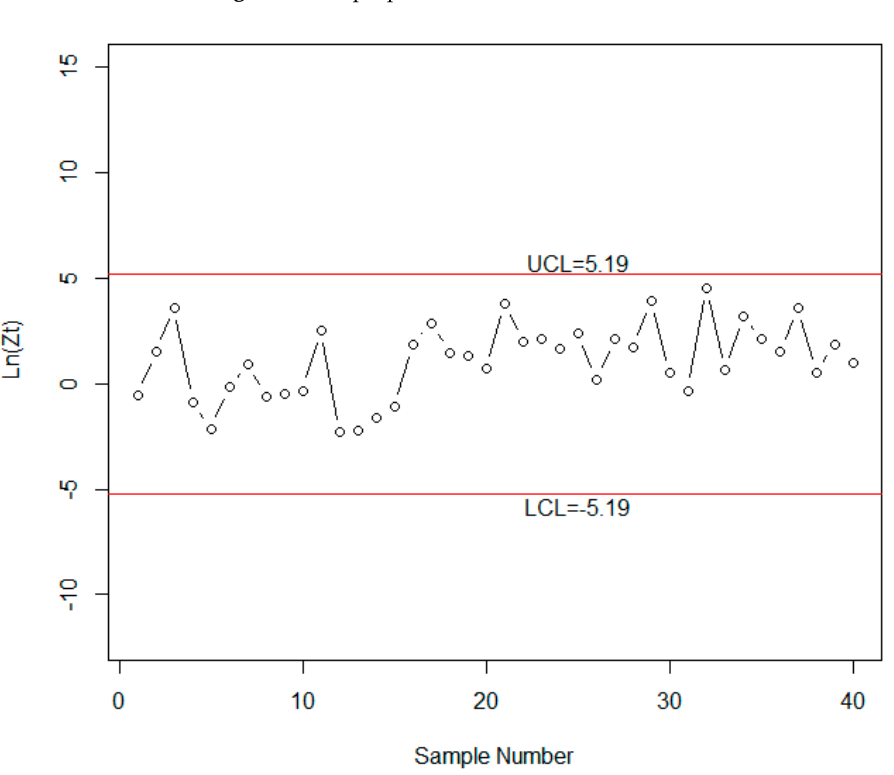
Figure 4. The existing chart for the real data.